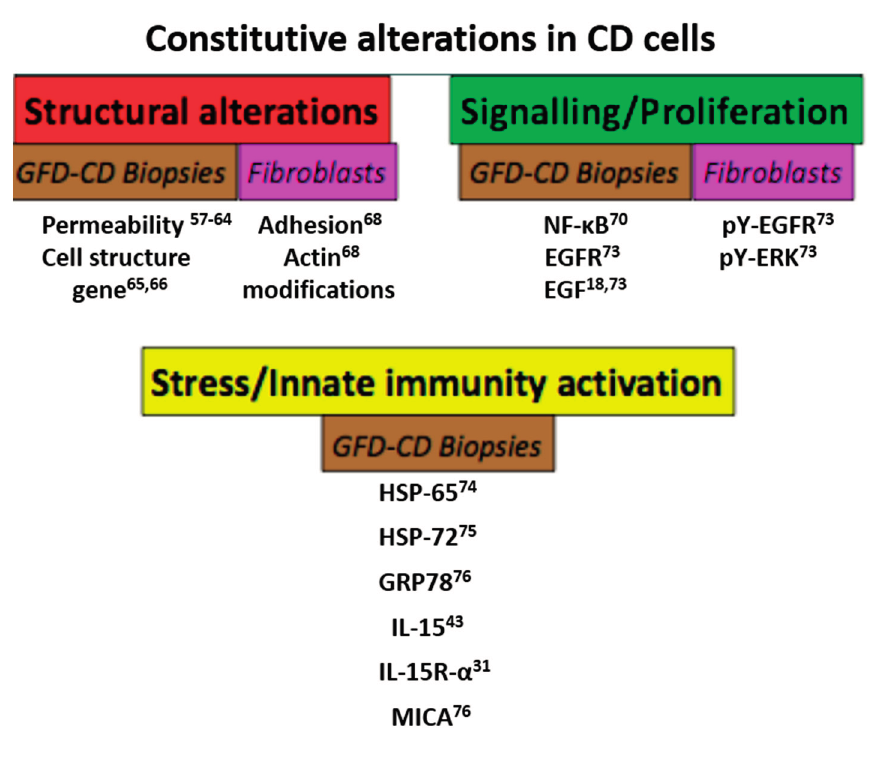
Figure 4. Constitutive alterations in cells and biopsies from CD patients. Schematic representation of constitutive alterations of CD cells and biopsies. These alterations have been described in gluten-free diet (GFD) CD patient cells and biopsies. The main constitutive alterations found in GFD CD cells and biopsies were grouped in three sets: Structural alterations (permeability, actin modifications, adhesion), signaling/proliferation (EGF/EGFR activation, NF- κ B, pY-ERK) and stress/innate immunity activation as shown. In all cases there was a quantitative increase in the markers cited, although in the case of actin, the alterations were qualitative. Numbers indicate the bibliographic